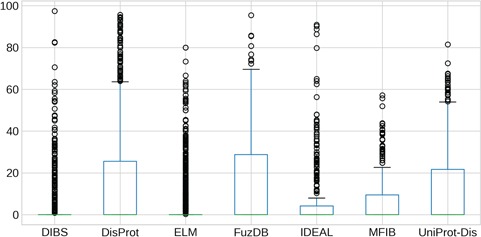
Quantification of LC content of IDRs. The y-axis is in logarithmic scale. Box plots of the content of LC per regions in each dataset. Whiskers represent the 25 and 75% of the data and outliers are shown as circles.